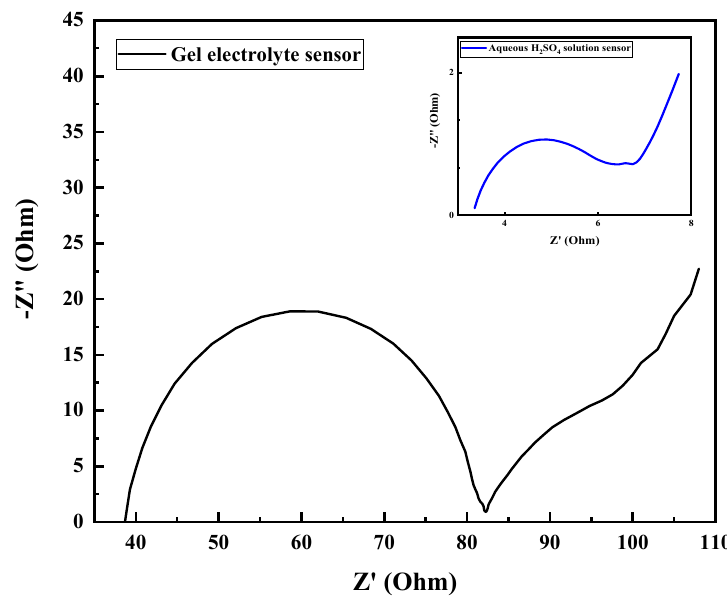
Figure 5. Electrochemical impedance spectra (EIS) of the SiO 2 gel electrolyte and the aqueous H 2 SO 4 solution sensors.